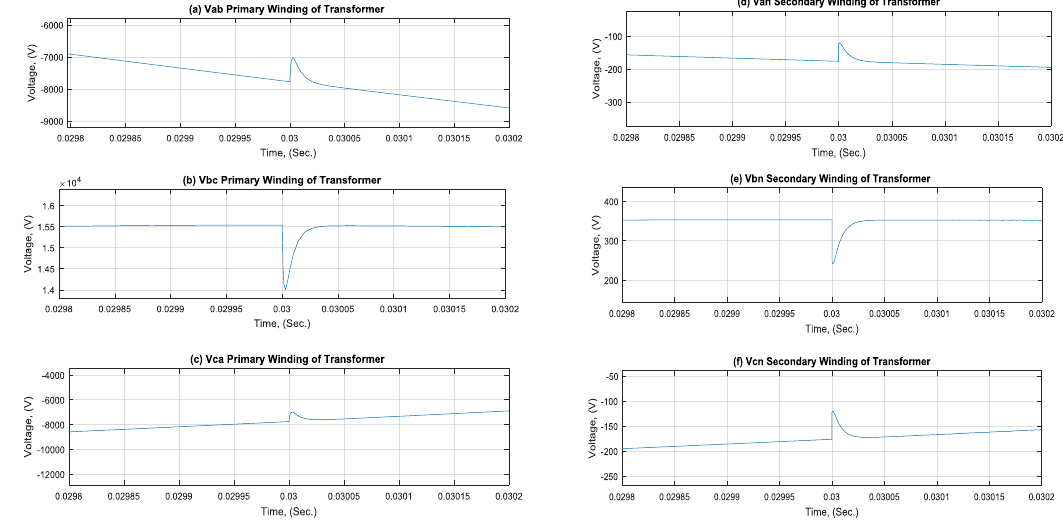
Figure 15. Impact of inrush current with a magnitude of 101 A on the primary and secondary terminal voltages of the 11 kV–400 V transformer.